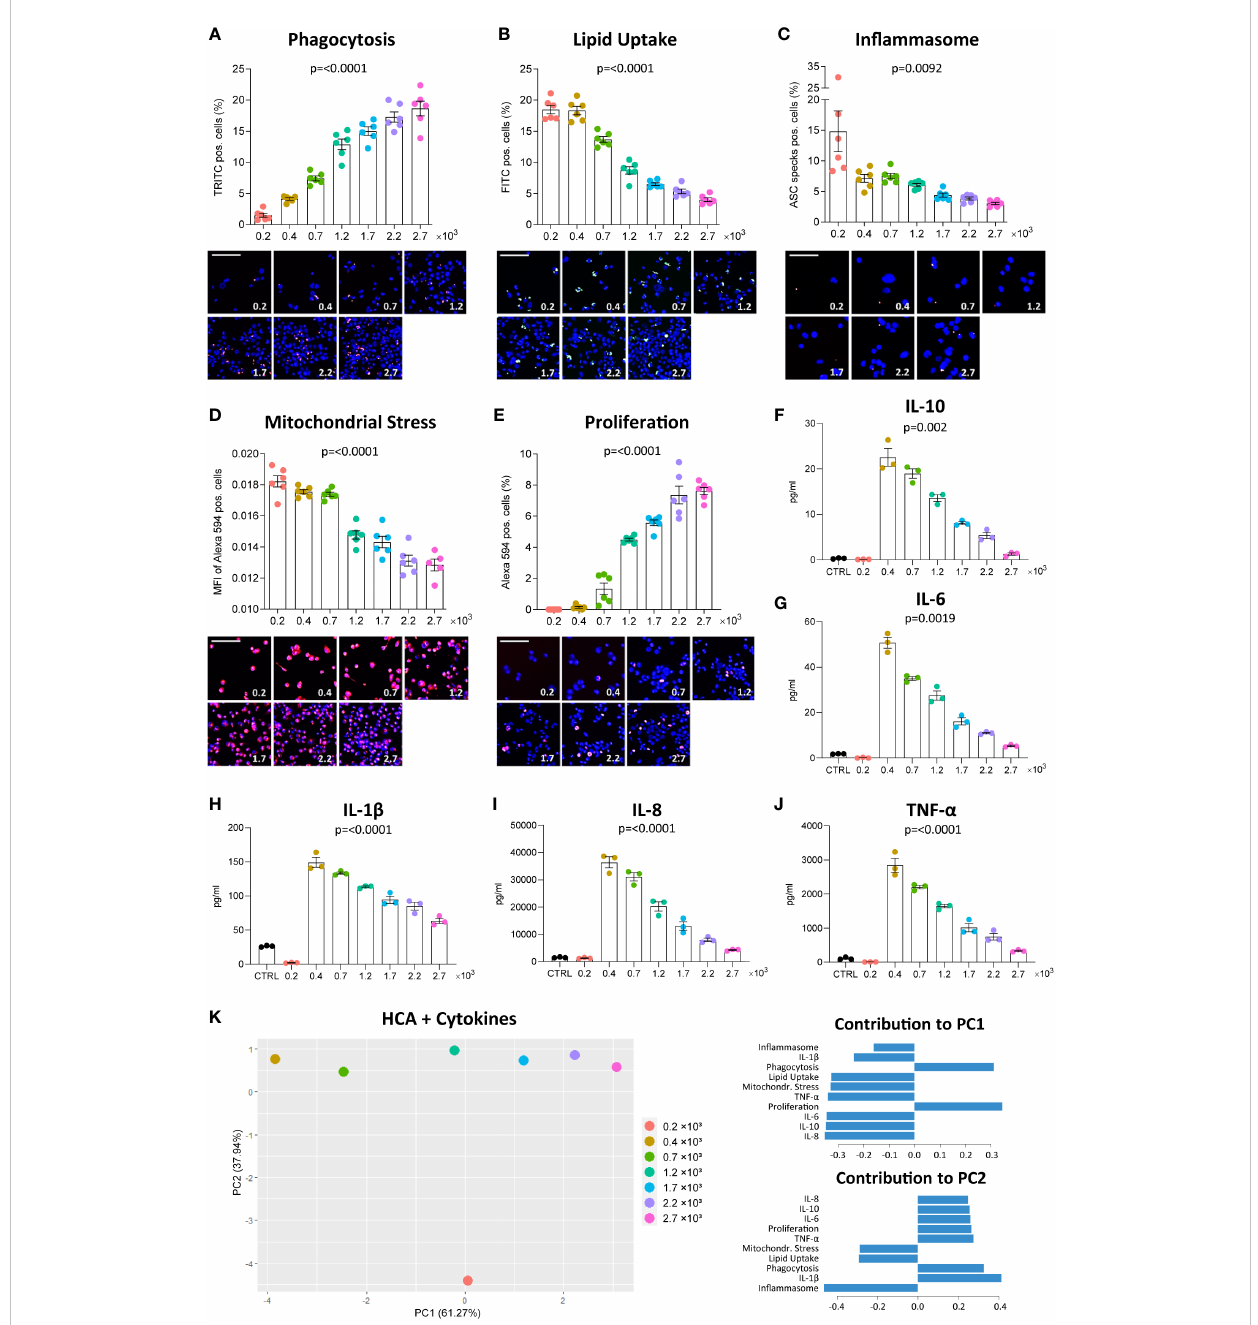
FIGURE 1 Density affects M F function. THP-1 cells were seeded at the respective densities (0.2-2.7 x 10 3 cells/mm²) and differentiated with 2000 nM PMA for 48 hours followed by a resting period of 24 hours. Phagocytosis of zymosan-coated beads (A , red ) , uptake of fl uorescently-labelled oxLDL (B , green ) , in fl ammasome activation (C , red ) , mitochondrial stress in response to staurosporine (D , red ) and EdU incorporation in proliferating cells (E , red ) were assessed using the fl uorescent imaging MacroScreen platform. Hoechst was used for nuclear labelling (blue). In the representative fl uorescent images, the scale bar refers to 50 m M. In the representative images for the in fl ammasome assay, the scale bar refers to 25 m M. Secretion of IL-10 (F) , IL-6 (G) , IL-1 b (H) , IL-8 (I) , and TNF- a (J) in response to 6-hour stimulation with 50 ng/ml LPS were measured by multiplex ELISA. Cells in the control (CTRL) condition were seeded at 1.7 x 10 3 cells/mm² and not stimulated with LPS. The indicated p-values refer to overall signi fi cance, p-values of all group comparisons can be found in Supplementary Table 1. (K) PCA plot of the high-content analysis (HCA) data and cytokine measurements with the factor loadings for PC1 and PC2. MFI: Mean fl uorescence